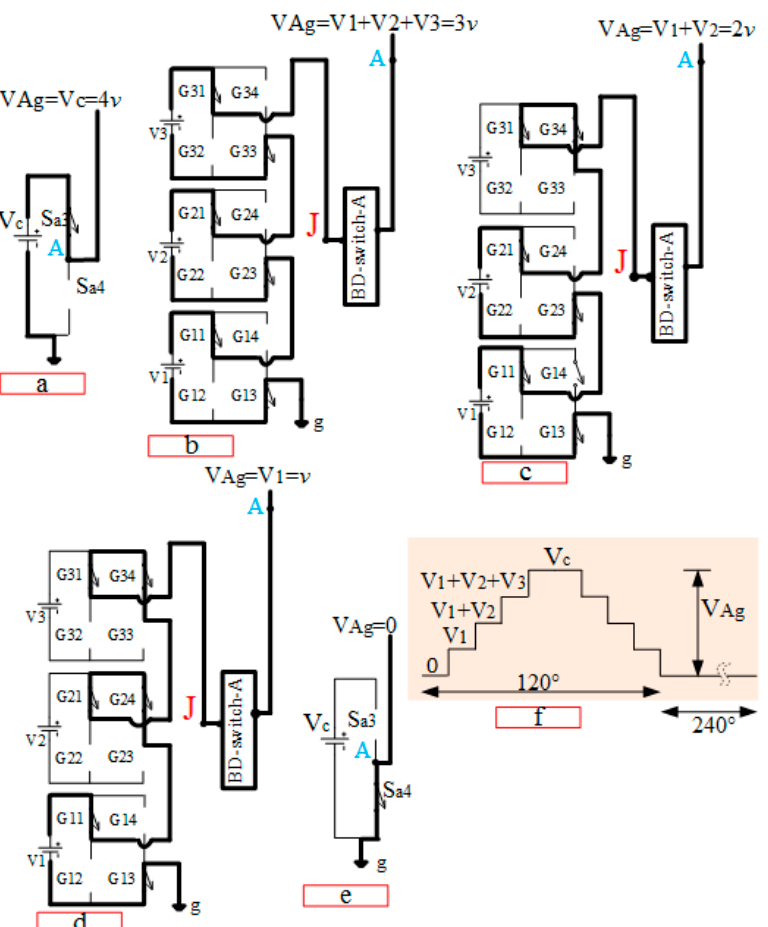
Figure 5. Different switching logics for generating four levels in the pole voltages: ( a ) level 3 v ; ( b ) Level 2 v ; ( c ) Level v ; ( d ) Level 0; ( e ) Complete cycle of the pole voltage. Reprint with permission [4261051118814]; 2018, IEEE.